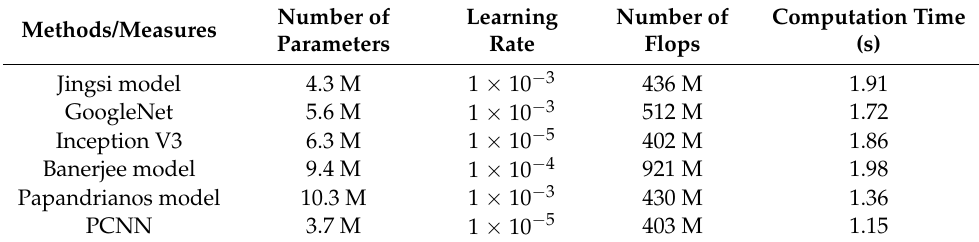
Table 12. Computational complexities of CNN for Dataset_2.